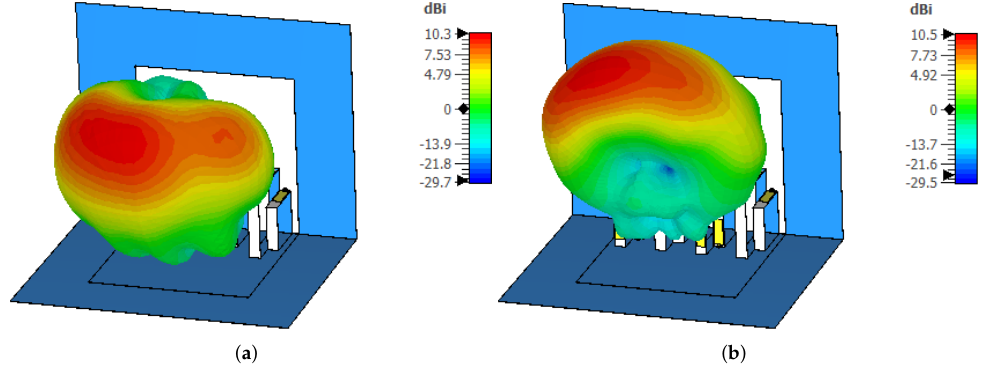
Figure 9. Three-dimensional patterns of the proposed Kirigami MIMO antenna for ( a ) antenna 1 and ( b ) antenna 2.